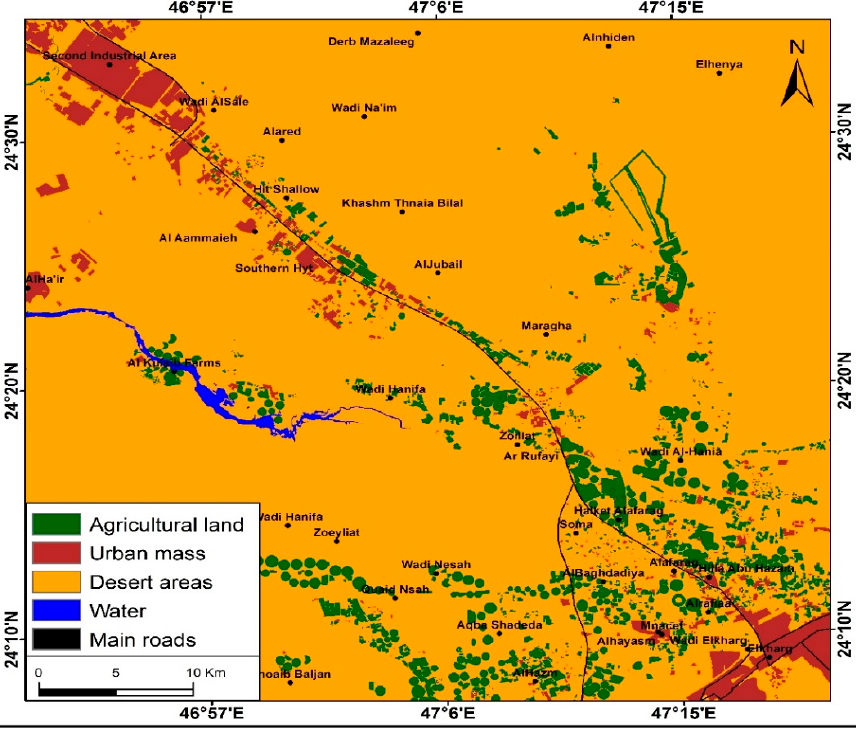
Figure 4. The land use of the rural–urban continuum between Ar Riyadh and Al Kharj cities, 2019.